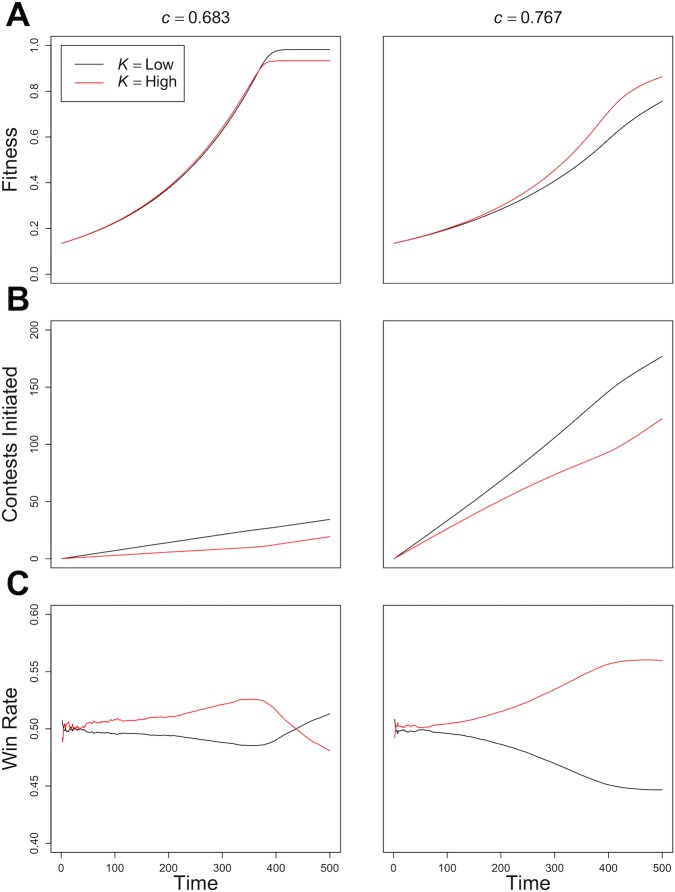
The Effects of K on Variables Within a Single Generation Over Time.The mean A) fitness, B) number of contests and C) win rate of individuals with K = 0.25 (black) and K = 0.85 (red) over time within one generation, when competition, c (Equation 3) is 0.683 (left panels) and 0.767 (right panels). Each panel is based on the results of 30 independent model runs, each with 75 individuals with each K value.